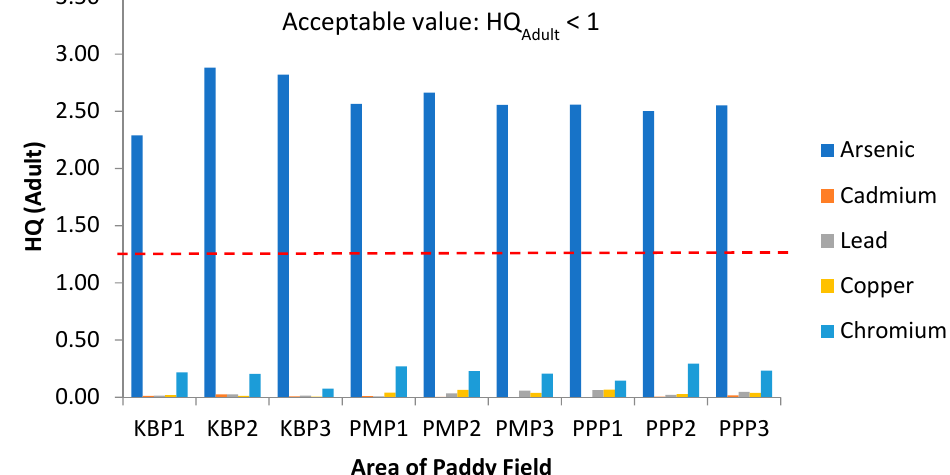
Figure 7. Hazard Quotient (HQ) values for adults via intake of rice from the three plots of sampling sites. KBP1: Kota Bharu Plot 1, KBP2: Kota Bharu Plot 2, KBP3: Kota Bharu Plot 3, PMP1: Pasir Mas Plot 1, PMP2: Pasir Mas Plot 2, PMP3: Pasir Mas Plot 3, PPP1: Pasir Puteh Plot 1, PPP2: Pasir Puteh Plot 2, and PPP3: Pasir Puteh Plot 3.